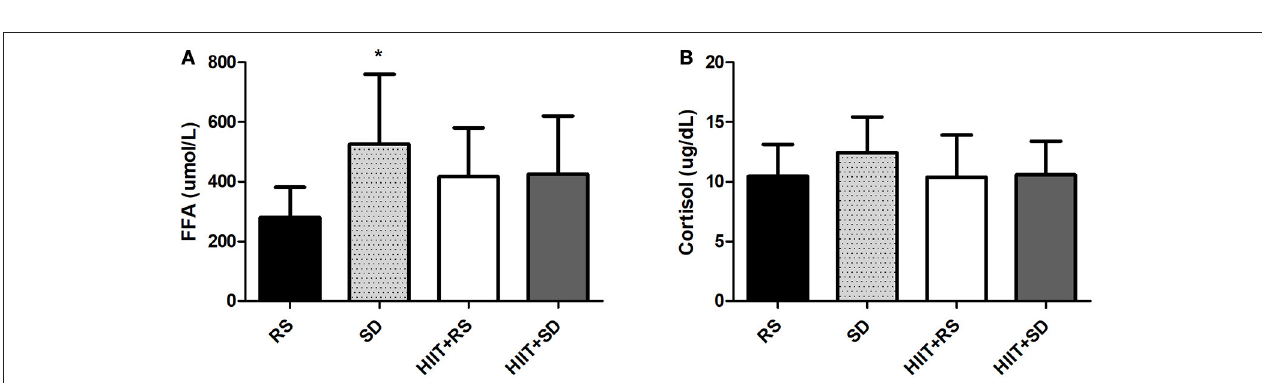
FIGURE 4 | Free fatty acids and cortisol. (A) Free Fatty Acids concentrations and (B) Cortisol concentrations. GLM with Post-Hoc Newman Keuls Test. Data presented as mean ± SD . *Different to RS